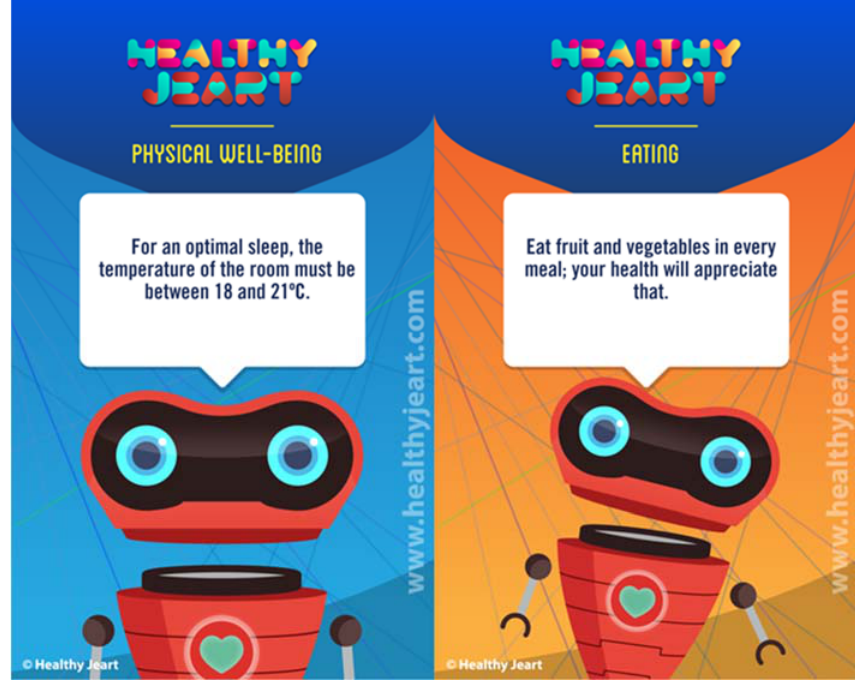
Figure 1. Examples of app tips.